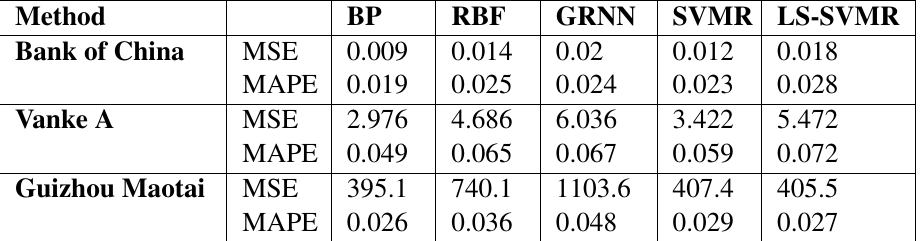
Table 2 Results of the five